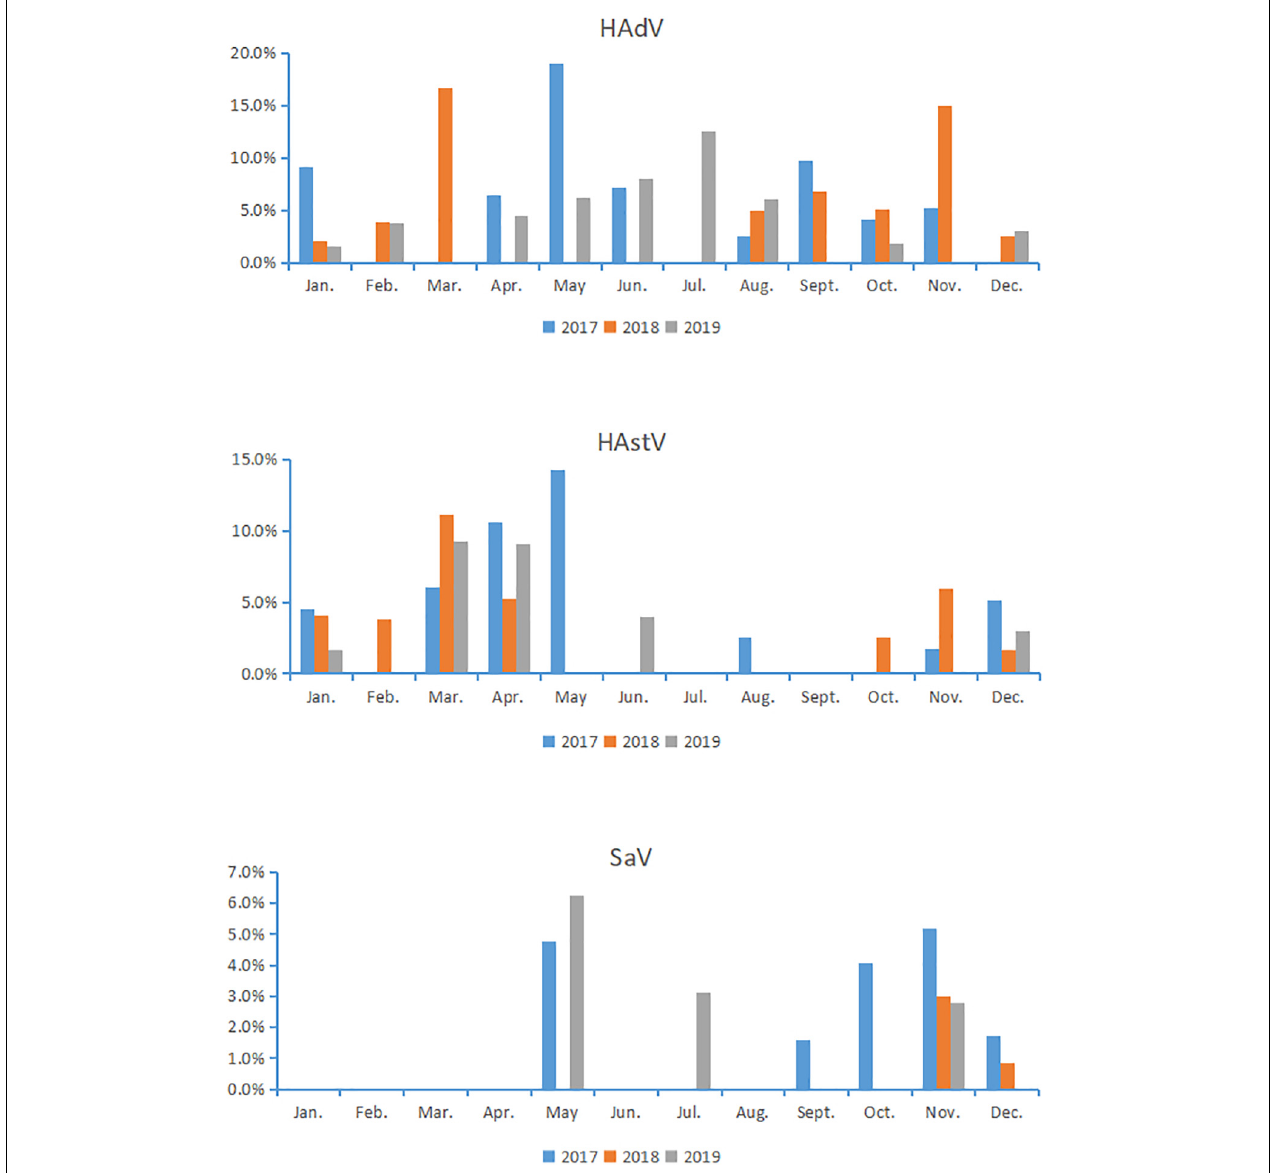
FIGURE 1 | Monthly distribution of sapovirus, astrovirus, and human adenovirus detection.